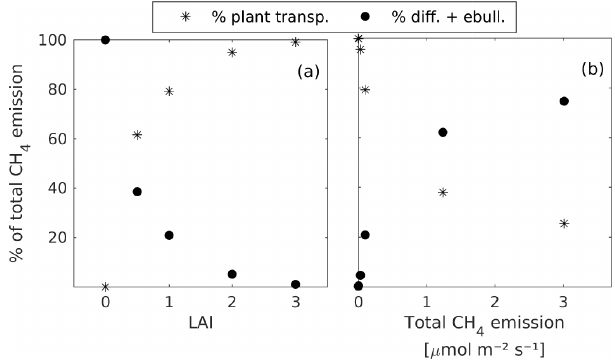
Figure 4. Contribution of different transport routes to the total CH 4 emission (a) as a function of LAI in test L_W0_T10_R1 and (b) as a function of total CH 4 emission in test